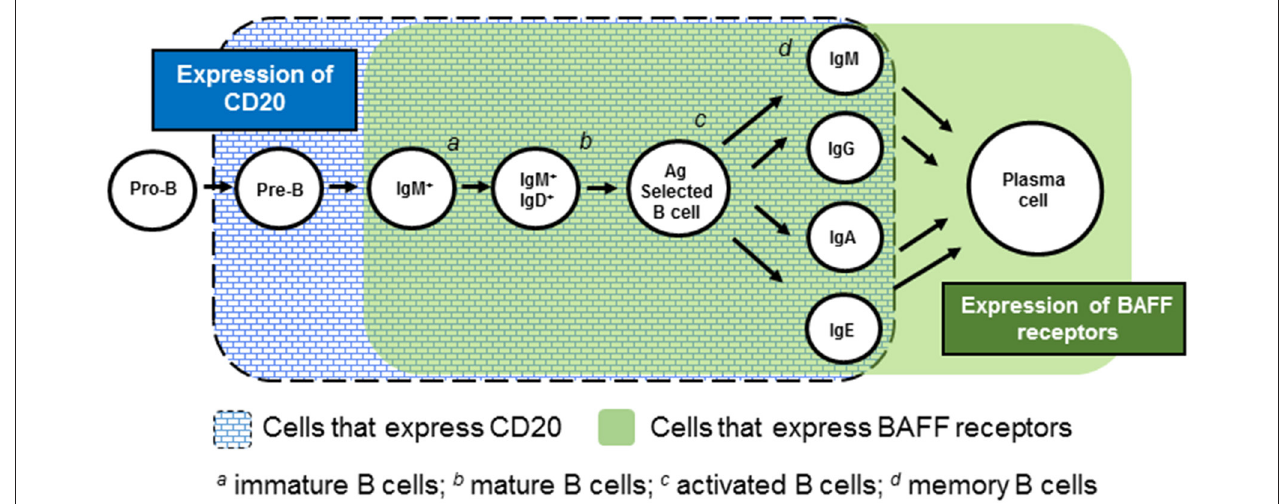
FIGURE 1 | Expression of CD20 and BAFF receptors during B cell